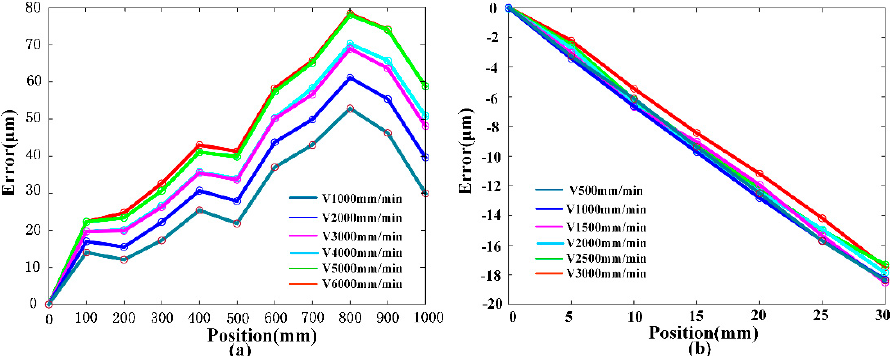
Figure 9. Positioning error curves of ∆ X x 1 and ∆ X x 2 . ( a ) x 1 -axis positioning error curve; ( b ) x 2 -axis positioning error curves.